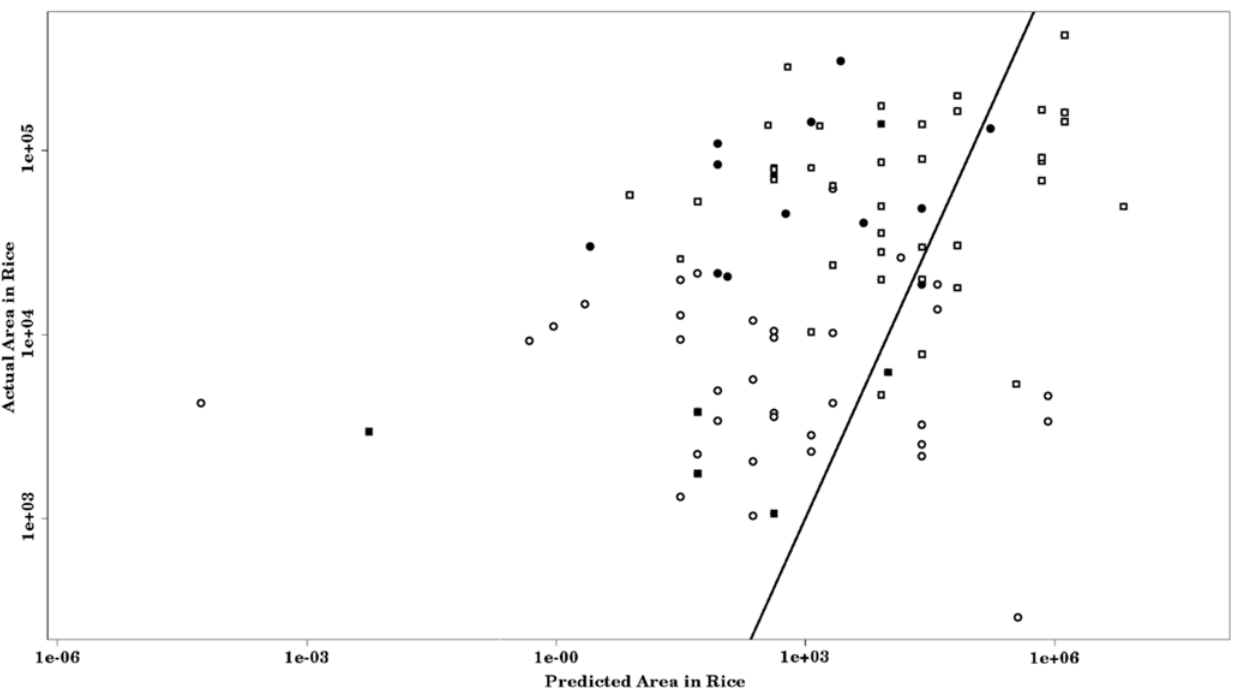
Figure 3. Actual area cultivated in rice plotted versus the predicted minimal area cultivated (from eqn. 5). Open symbols indicate households in villages closer to large urban markets via road (Sambivinany – circle, Sahateja – square). Closed symbols are from villages where households are more likely to be isolated from urban markets (Marjorano – circle, Tsinjorano – square). The line indicates where actual area cultivated is equal to predicted area